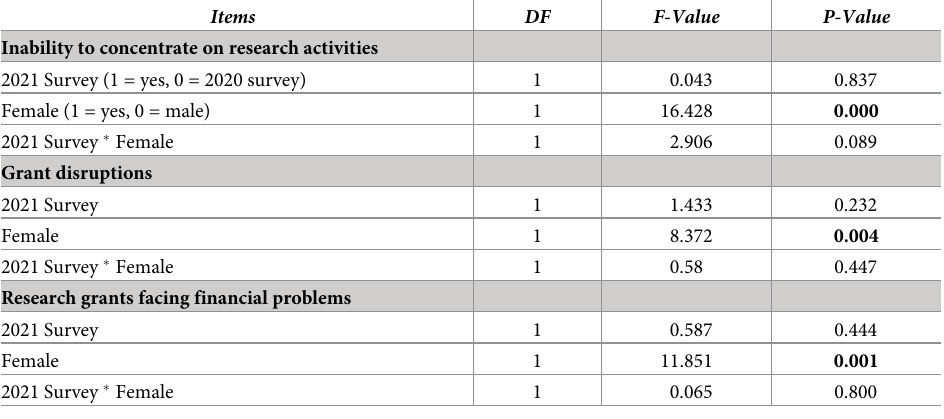
Table 6. Two-way ANOVA regarding the items: Inability to concentrate on research activities; grant disruptions; research grants facing financial problems. Items DF F-Value P-Value Inability to concentrate on research